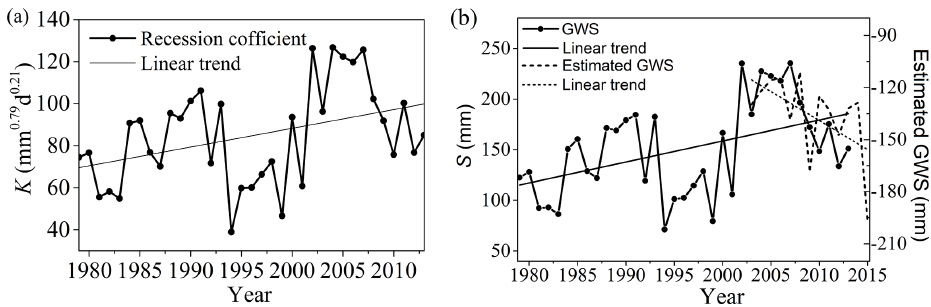
Figure 9. Variations in (a) the recession coefficient K and (b) the estimated groundwater storage S from 1979 to 2013 as well as the estimated groundwater storage changes from 2003 to 2015 from GRACE data.